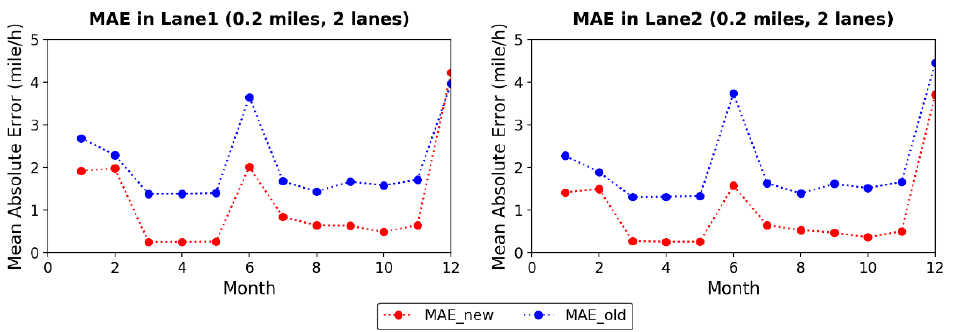
Figure 4. MAE curves of the new system and the old system in segment {0.2 miles, 2 lanes}.